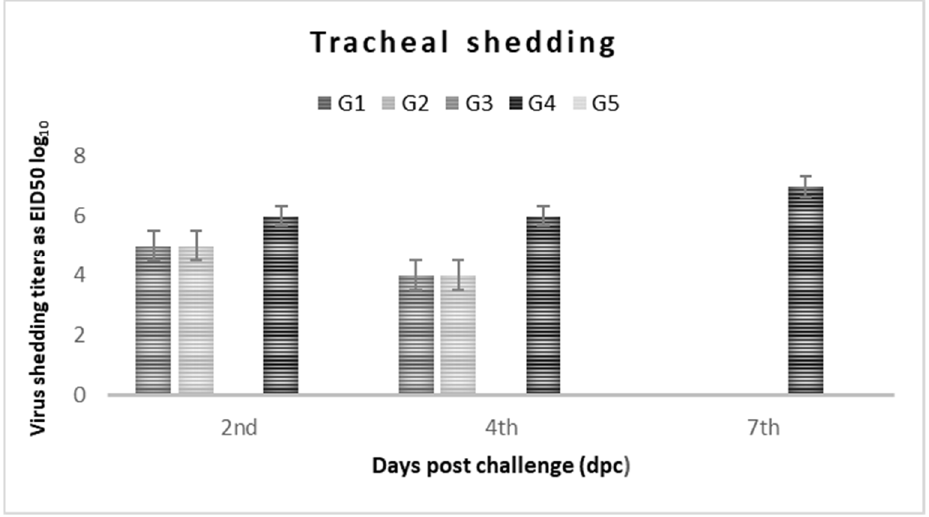
Figure 3. Tracheal shedding titers log 10 EID 50 /1 mL (±SD) in vaccinated and non-vaccinated broiler chickens at dpc.